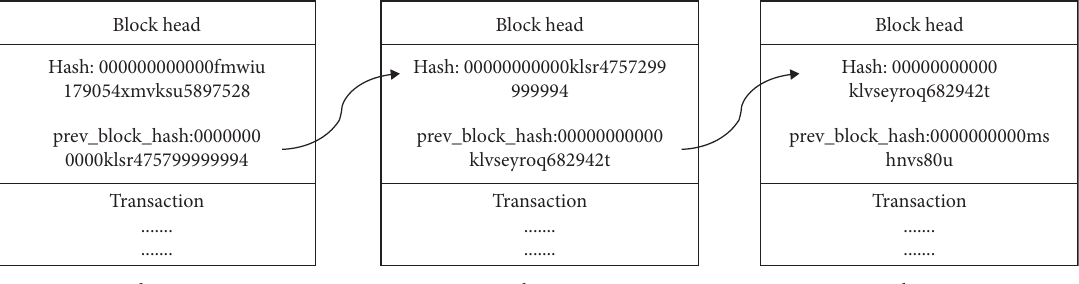
Figure 4: Blockchain